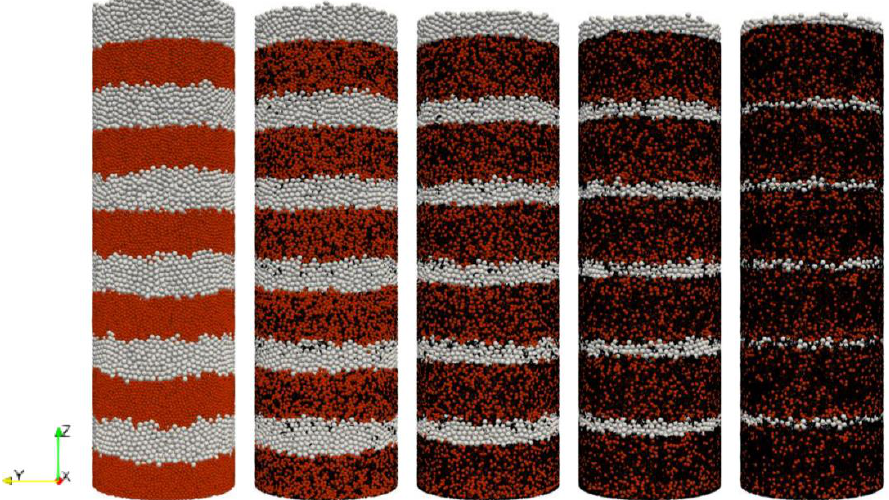
Figure 16. Stock column-structure variances with different nut coke mixing ratios (gray: coke; red: ore; black: nut coke).